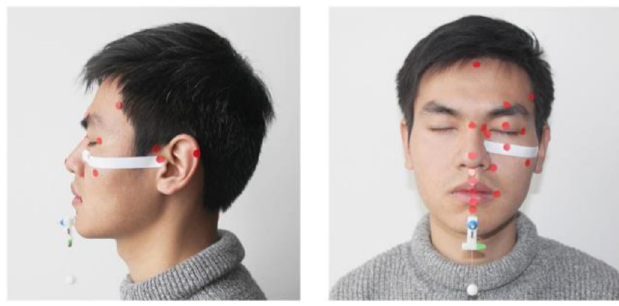
Fig. 10. Acquisition of the head data.